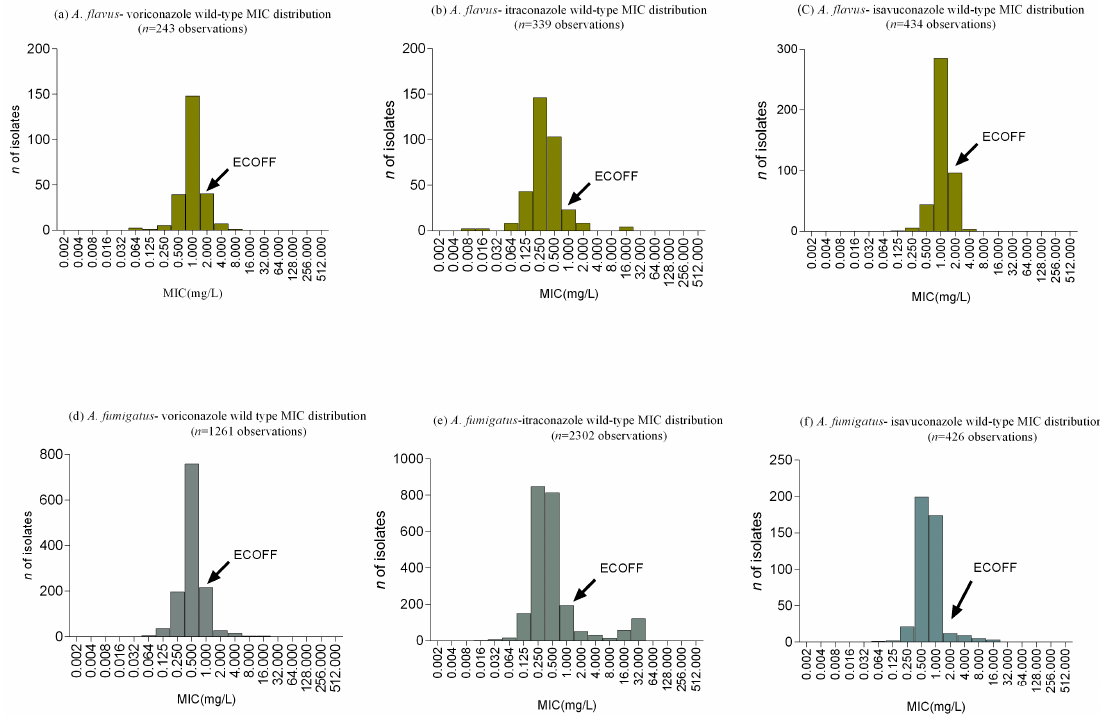
Figure 1. Comparison of European Committee on Antimicrobial Susceptibility testing wild-type azole minimum inhibitory concentrations distribution of A. flavus and A.